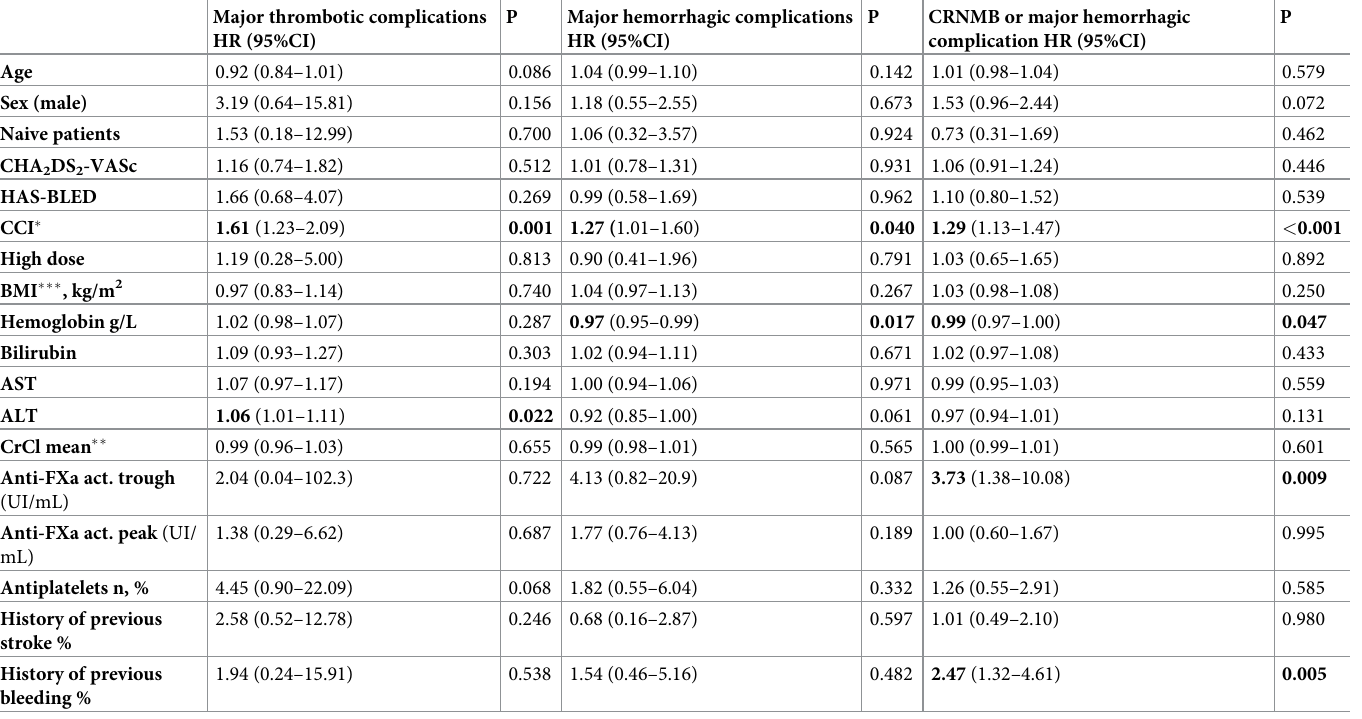
Table 3. Clinical and laboratory characteristics related to thrombotic and hemorrhagic complications in the edoxaban cohort. Major thrombotic complications HR